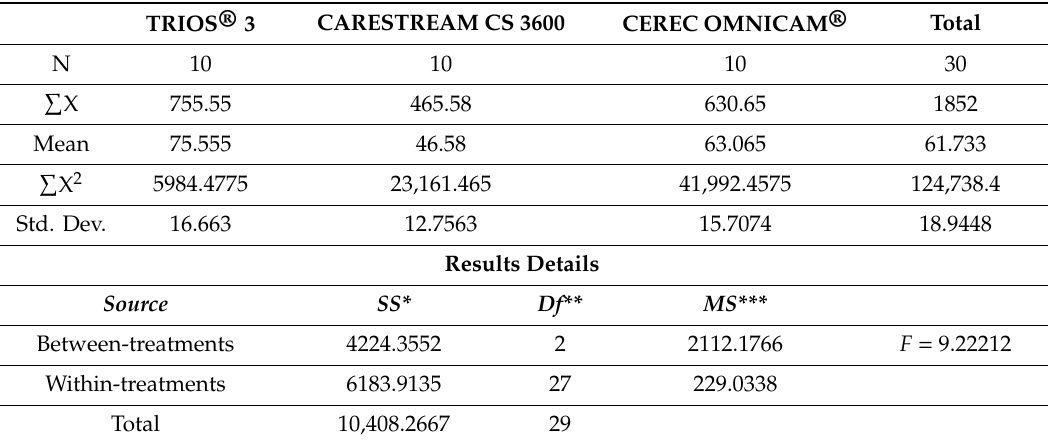
Table 8. Distance between reference lines and test ones in sample 3 without saliva.